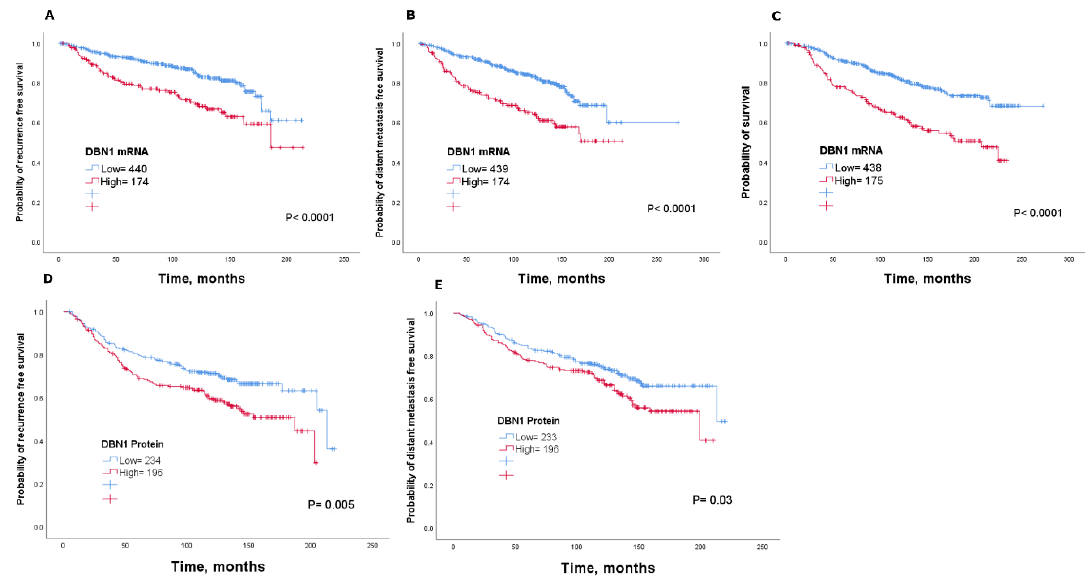
Figure 3. Association of DBN1 mRNA and DBN1 protein with patient outcome in all luminal breast cancer irrespective of treatment using the METABRIC cohort: ( A ) recurrence, ( B ) distant metastasis and ( C ) survival; and the Nottingham cohort: ( D ) recurrence and ( E ) distant metastasis. Table 1. Multivariate cox analysis of the associations between DBN1 expression and the clinicopathological parameters in all luminal breast cancer irrespective of treatment. METABRIC Cohort Recurrence-Free Survival Parameters